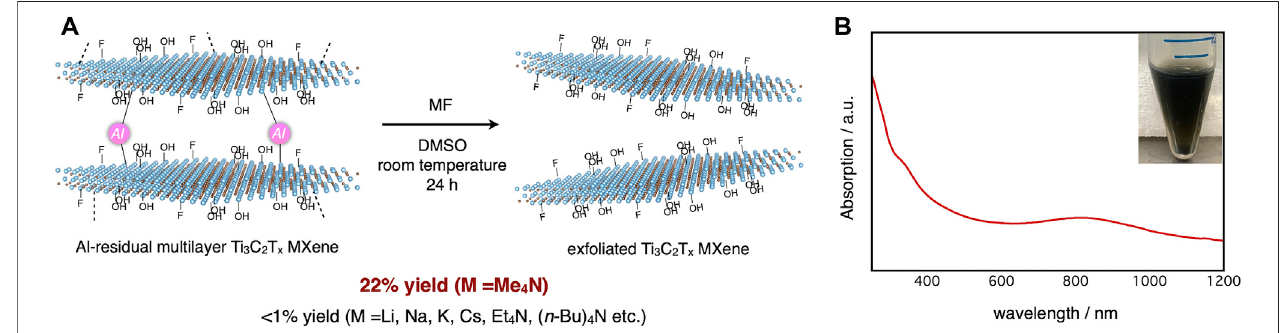
FIGURE 1 | (A) Exfoliation of Al-residual Ti 3 C 2 T x MXene with Me 4 NF; (B) Optical absorption spectrum (main) and typical photograph (inset) of Ti 3 C 2 T x MXene dispersion.